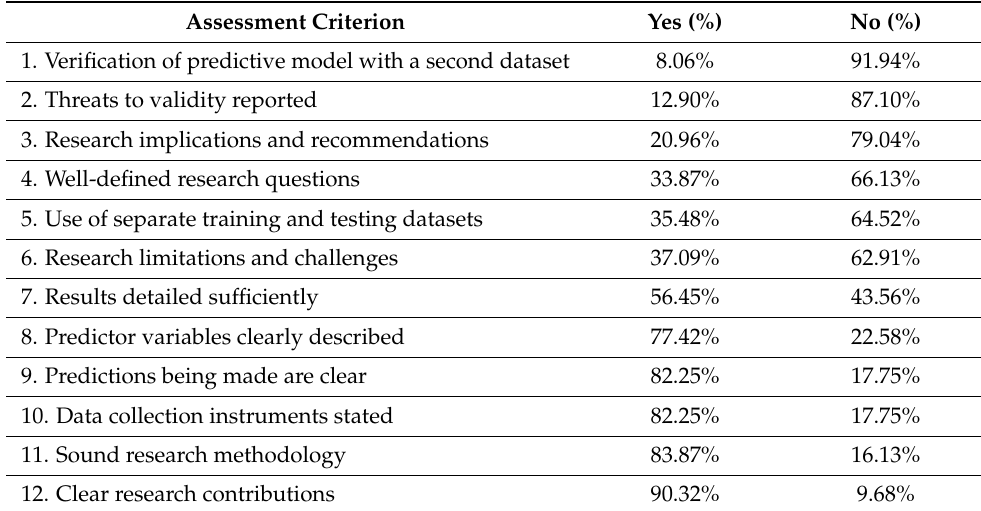
Table 10. Quality assessment of surveyed studies; Yes = Condition satisfied, No = Condition not